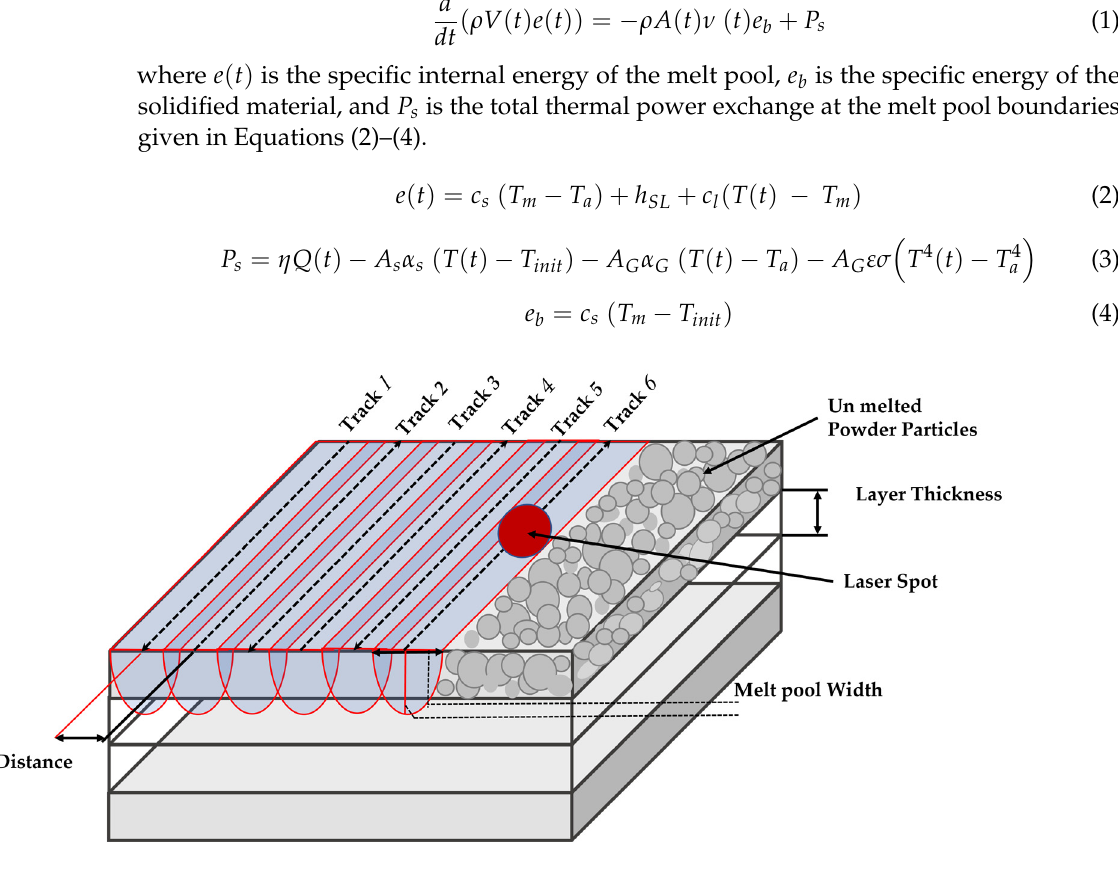
Figure 1. Schematics of the laser scanning pattern and the process parameters in SLM.